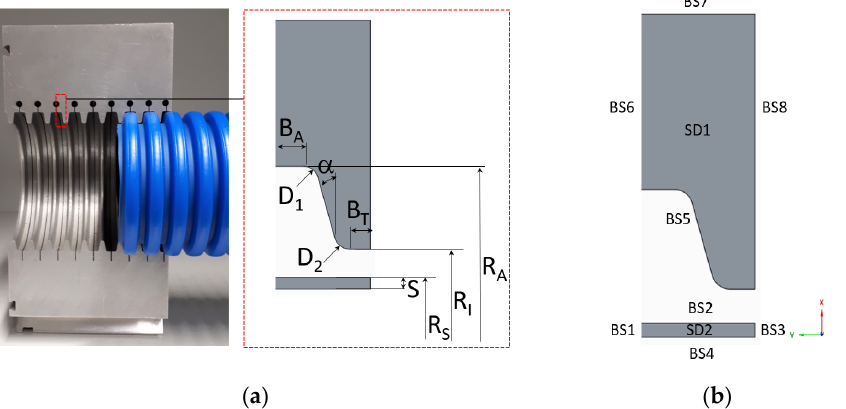
Figure 2. ( a ) 3D Mold block geometry on which the 2D axisymmetric model is based; ( b ) simulation boundary conditions.